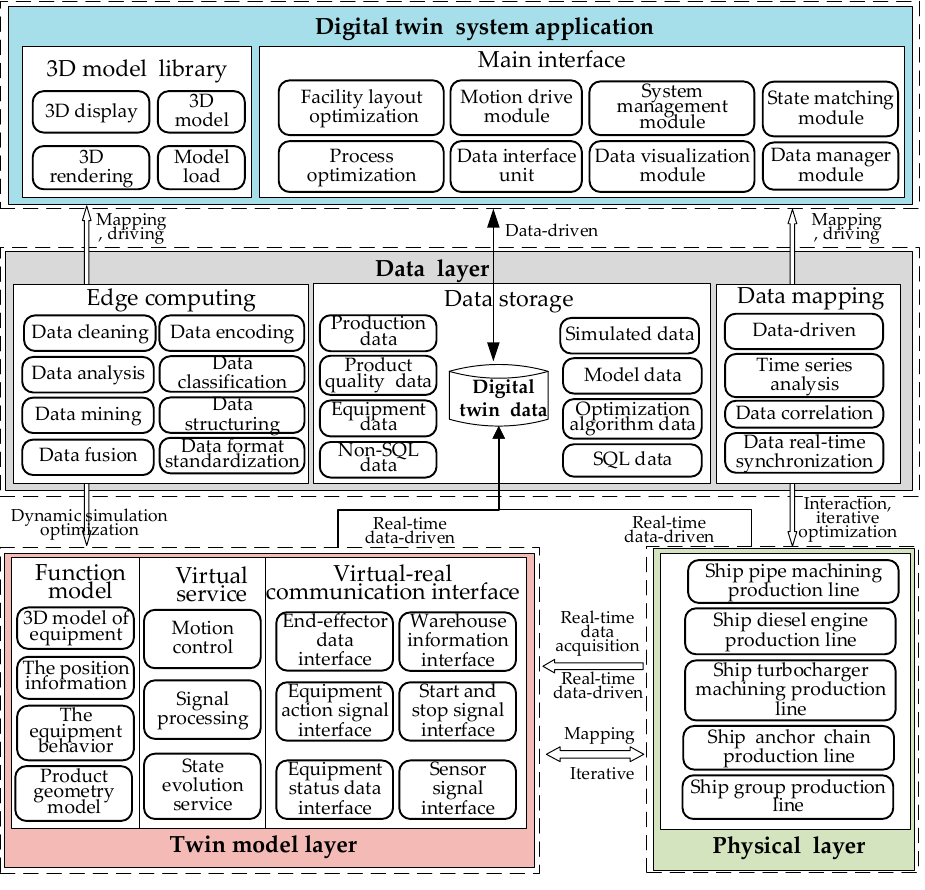
Figure 2. Expansion of twin model layer, data layer, and digital twin system application in Figure 1.